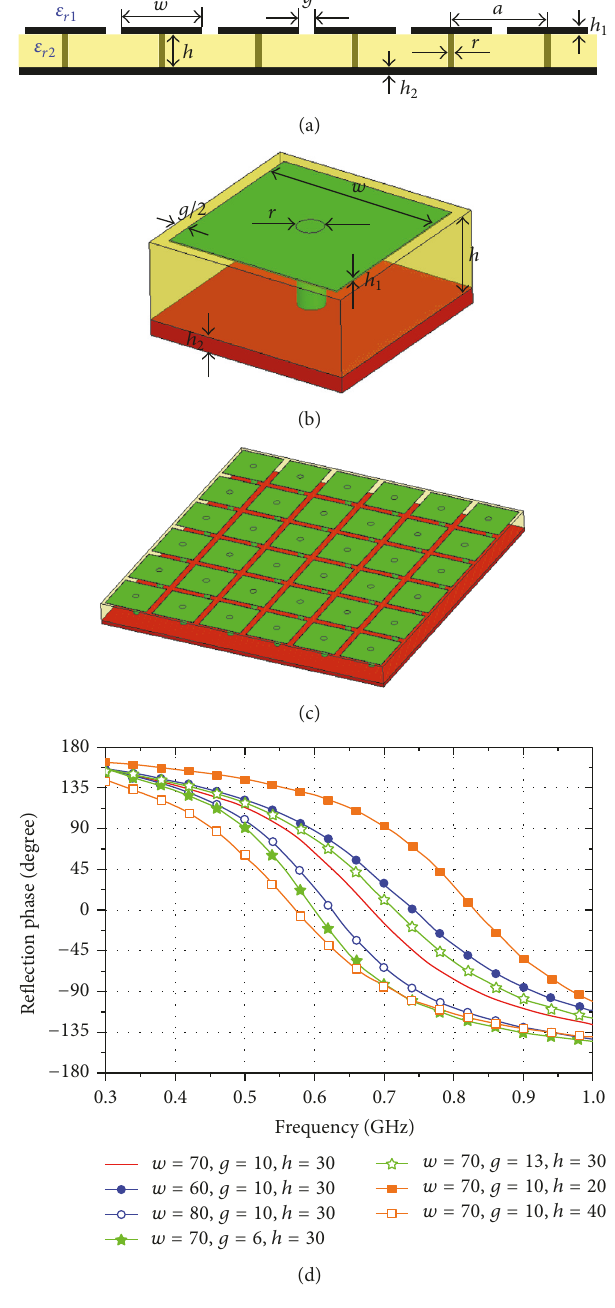
Figure 1: The proposed HIS structure: (a) HIS cross-sectional view, (b) the unit cell, (c) proposed 6 × 6 HIS array, and (d) reflection phase